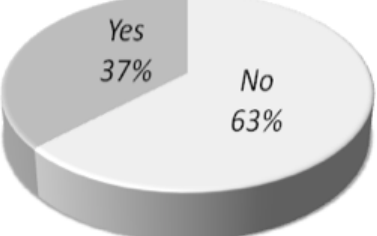
Figure 1: showing the subjects awareness of the importance of properly fitted spectacles.